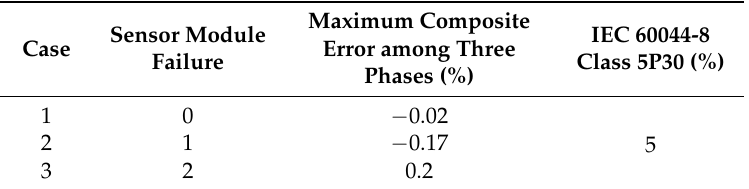
Table 5. Maximum composite errors of the proposed HCT when three-phase currents are unbalanced and a single-to-line fault occurs in R phase.